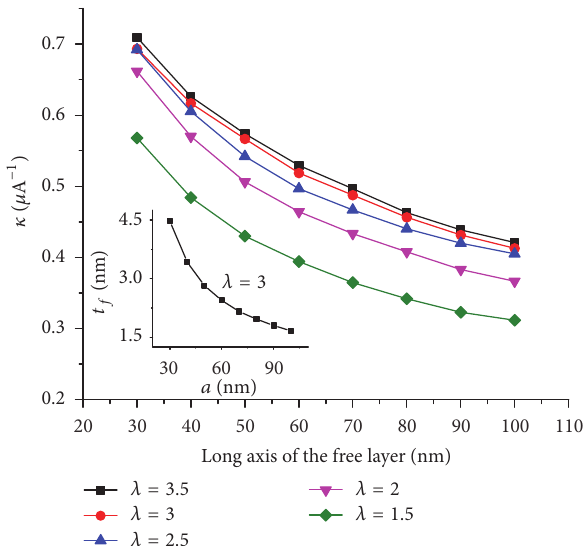
Figure 10: Geometric dependence of spin torque switching effi- ciency with fixed thermal stability Δ = 40. The inset shows the corresponding adjustment of thickness of free layer with 𝜆 =